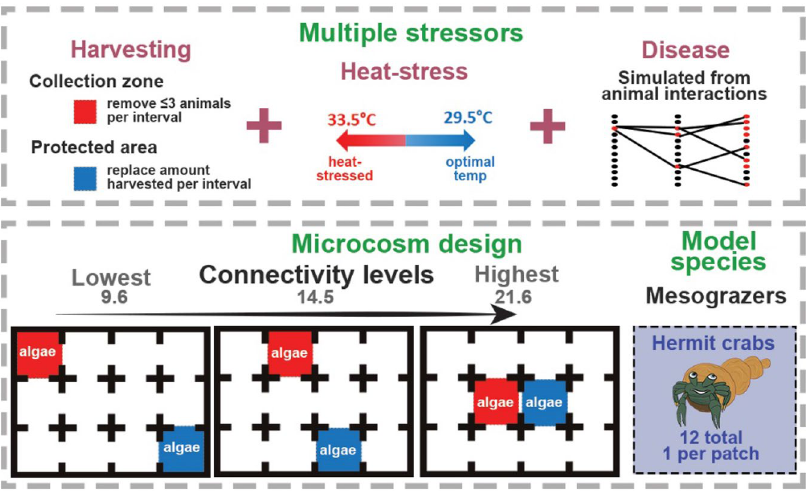
Figure 1. Experimental design with multiple stressors (top) and connectivity levels (bottom). Stressors were applied individually and in combination. Algal pellets were added into the coloured patches, with the amount consumed recorded at each